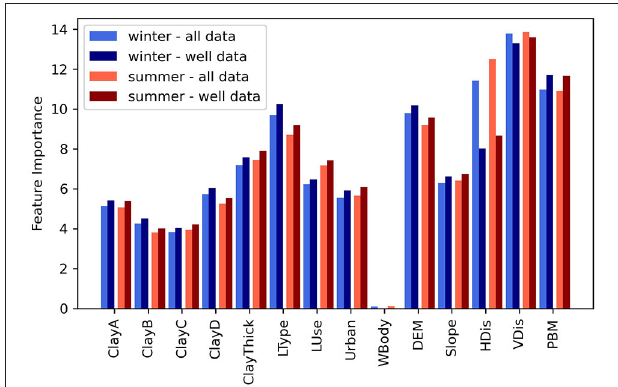
FIGURE 6 | Covariate importance quantified as prediction change in % calculated for summer and winter model for two subsets of training data (all data and well data only). The covariate abbreviations are explained in Table 2